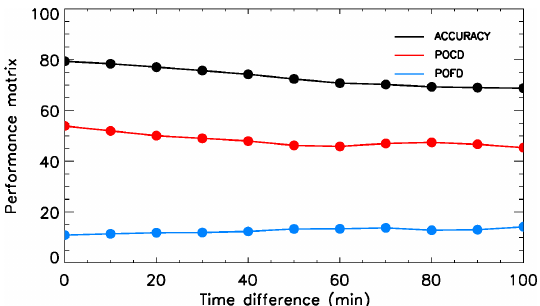
Figure 11. Performance metrics for January 2017 as a function of time difference between EPIC and GEO/LEO instrument measure- ments. POCD: probability of correct detection; POFD: probability of false